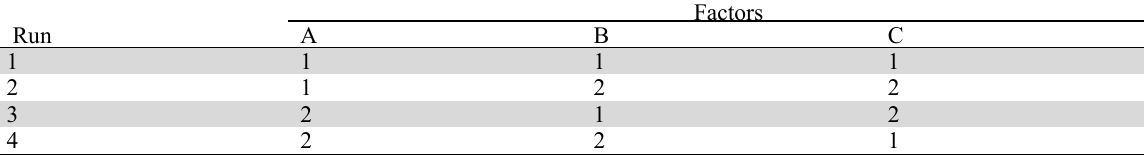
L 4 Orthogonal array